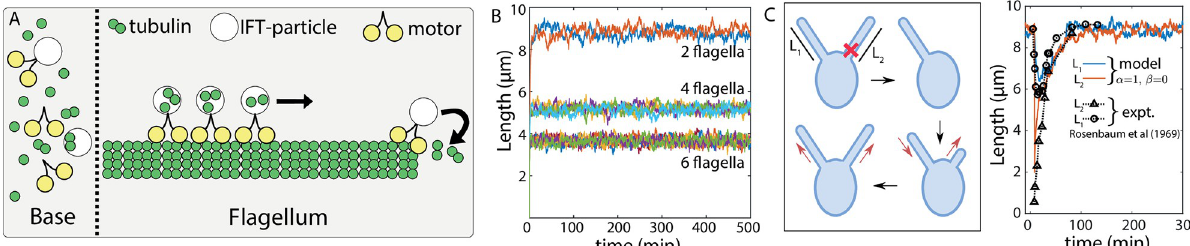
Fig 3. Flagellar size regulation. (A) Flagellum assembly in C. reinhardtii is regulated by IFT particles that incorporate tubulin dimers at the flagellum tip. This assembly process combined with the conservation of IFT amount in flagellum gives rise to an assembly rate that decreases with flagellum length. (B) Decrease in flagellar size with increasing number of flagella while the cell size is kept constant. (C, Left) We model the flagellar re-growth experiment [28], where one of the two flagella is amputated and regrowth is observed. The intact flagellum starts shrinking immediately after the amputation, indicating a shared pool of building blocks. (C, Right) Fit to the experimental data for the length dynamics of the two flagella with the growth curves from simulation show good quantitative agreement. The plotted time shows the duration after amputation. Parameters: tubulin concentration = 5 μ M, α = 1, β = 0, tubulin size = 10 nm, k + = 120 μ m 3 min − 1 , k − = 100 min − 1 , t 0 = 1000 min, production rate of new subunits r 0.0016 min − 1